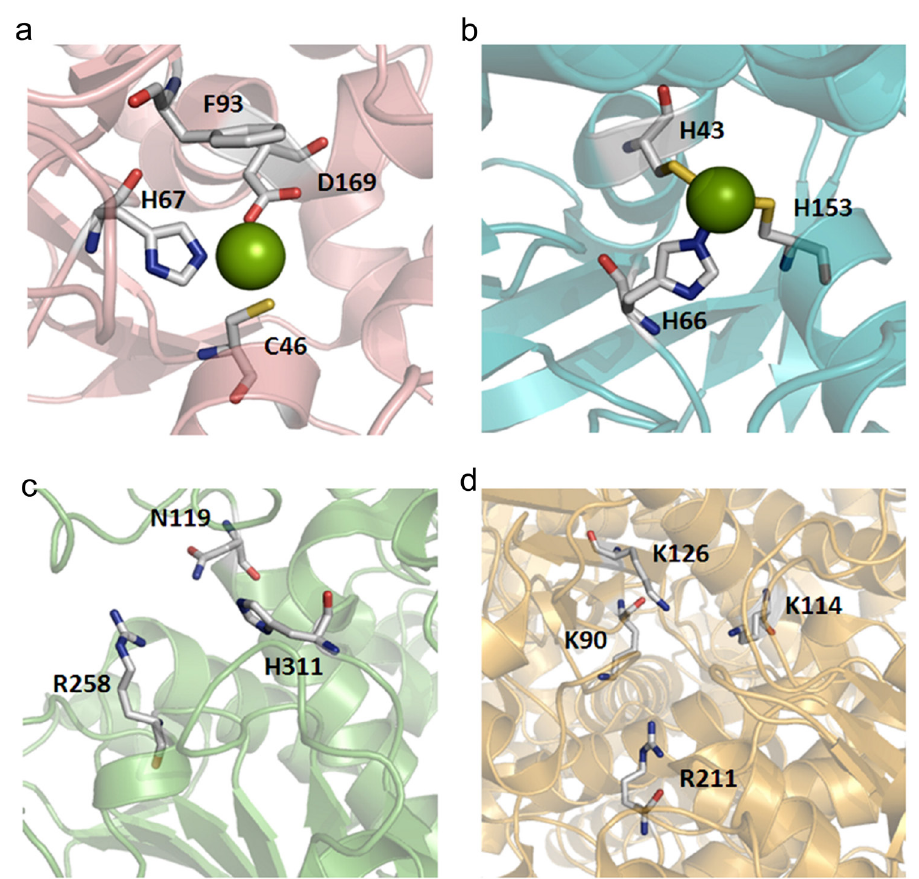
-methanol cycle enzymes: ( a ) FalDH, ( b ) 2